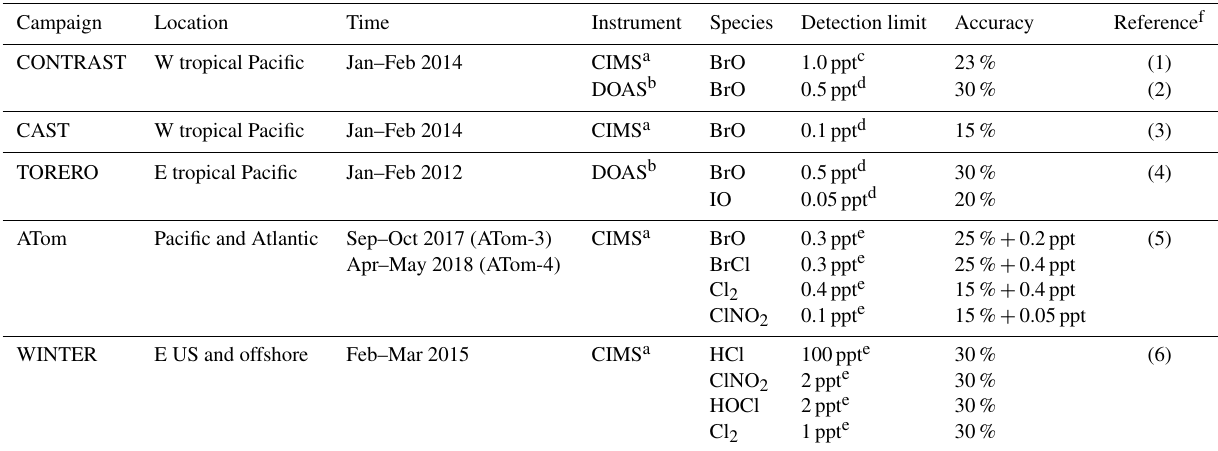
Figure 6. Median vertical profiles of BrO mixing ratios from the CONTRAST (January–February 2014 over the western tropical Pacific), CAST (January–February 2014 over the western tropical Pacific), TORERO (January–February 2012 over the eastern tropical Pacific), ATom-3 (September–October 2017 over the Pacific and Atlantic), and ATom-4 (April–May 2018 over the Pacific and Atlantic) campaigns. Observations are shown as medians in 1km vertical bins. Model values are shown as medians sampled along the flight tracks. There are two independent CONTRAST BrO data sets. The solid black line shows the chemical ionization mass spectrometer (CIMS) data from Chen et al. (2016). The dashed black line shows the differential optical absorption spectroscopy (DOAS) data from Koenig et al. (2017). The solid and dashed red lines show model values sampled along the flight tracks at the time of the available CIMS and DOAS observations, respectively. Table 4. Summary of aircraft